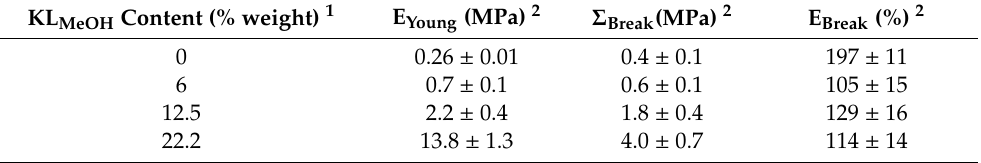
Table 3. Influence of the lignin content on the mechanical properties of the cured epoxy